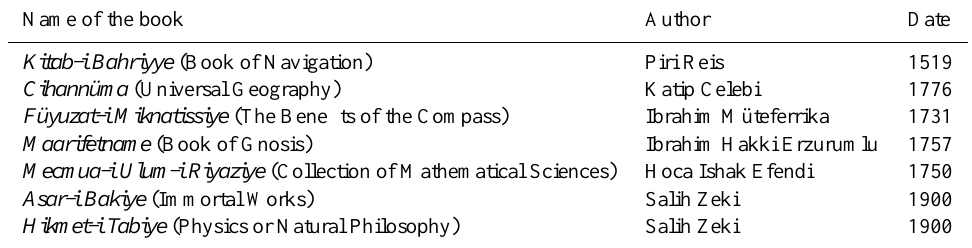
Table 2a. Direct and indirect geophysical books written in Turkey before 1920 (Özçep and Özçep, 1994).